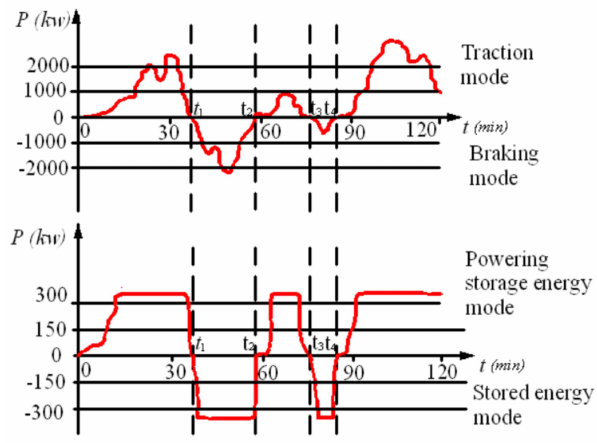
Figure 3. The traction and braking mode during a journey